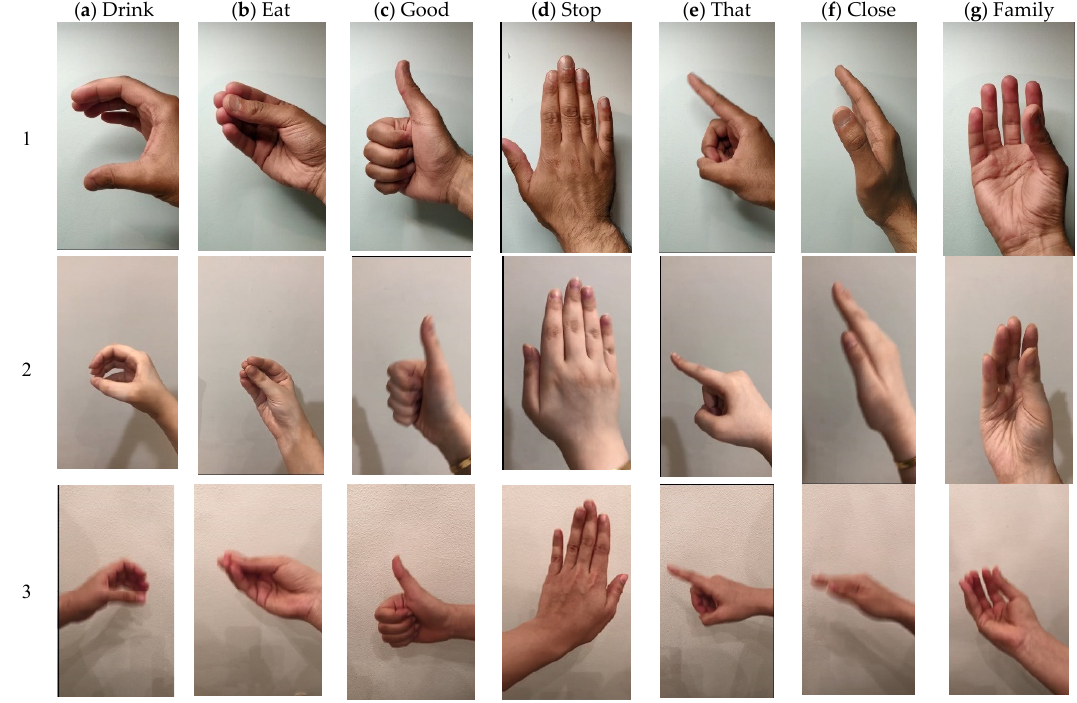
Figure 9. Seven universal hand gestures for three different subjects.